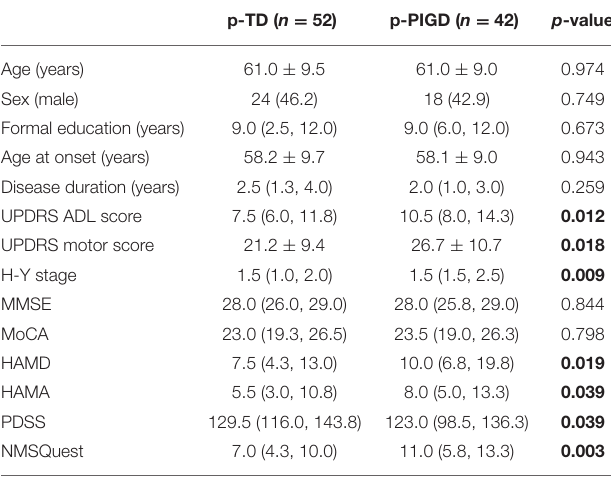
TABLE 4 | Comparison of the demographic and clinical characteristics of de novo Parkinson’s disease patients between the predominantly tremor-dominant and predominantly postural instability and gait difficulty subgroups.